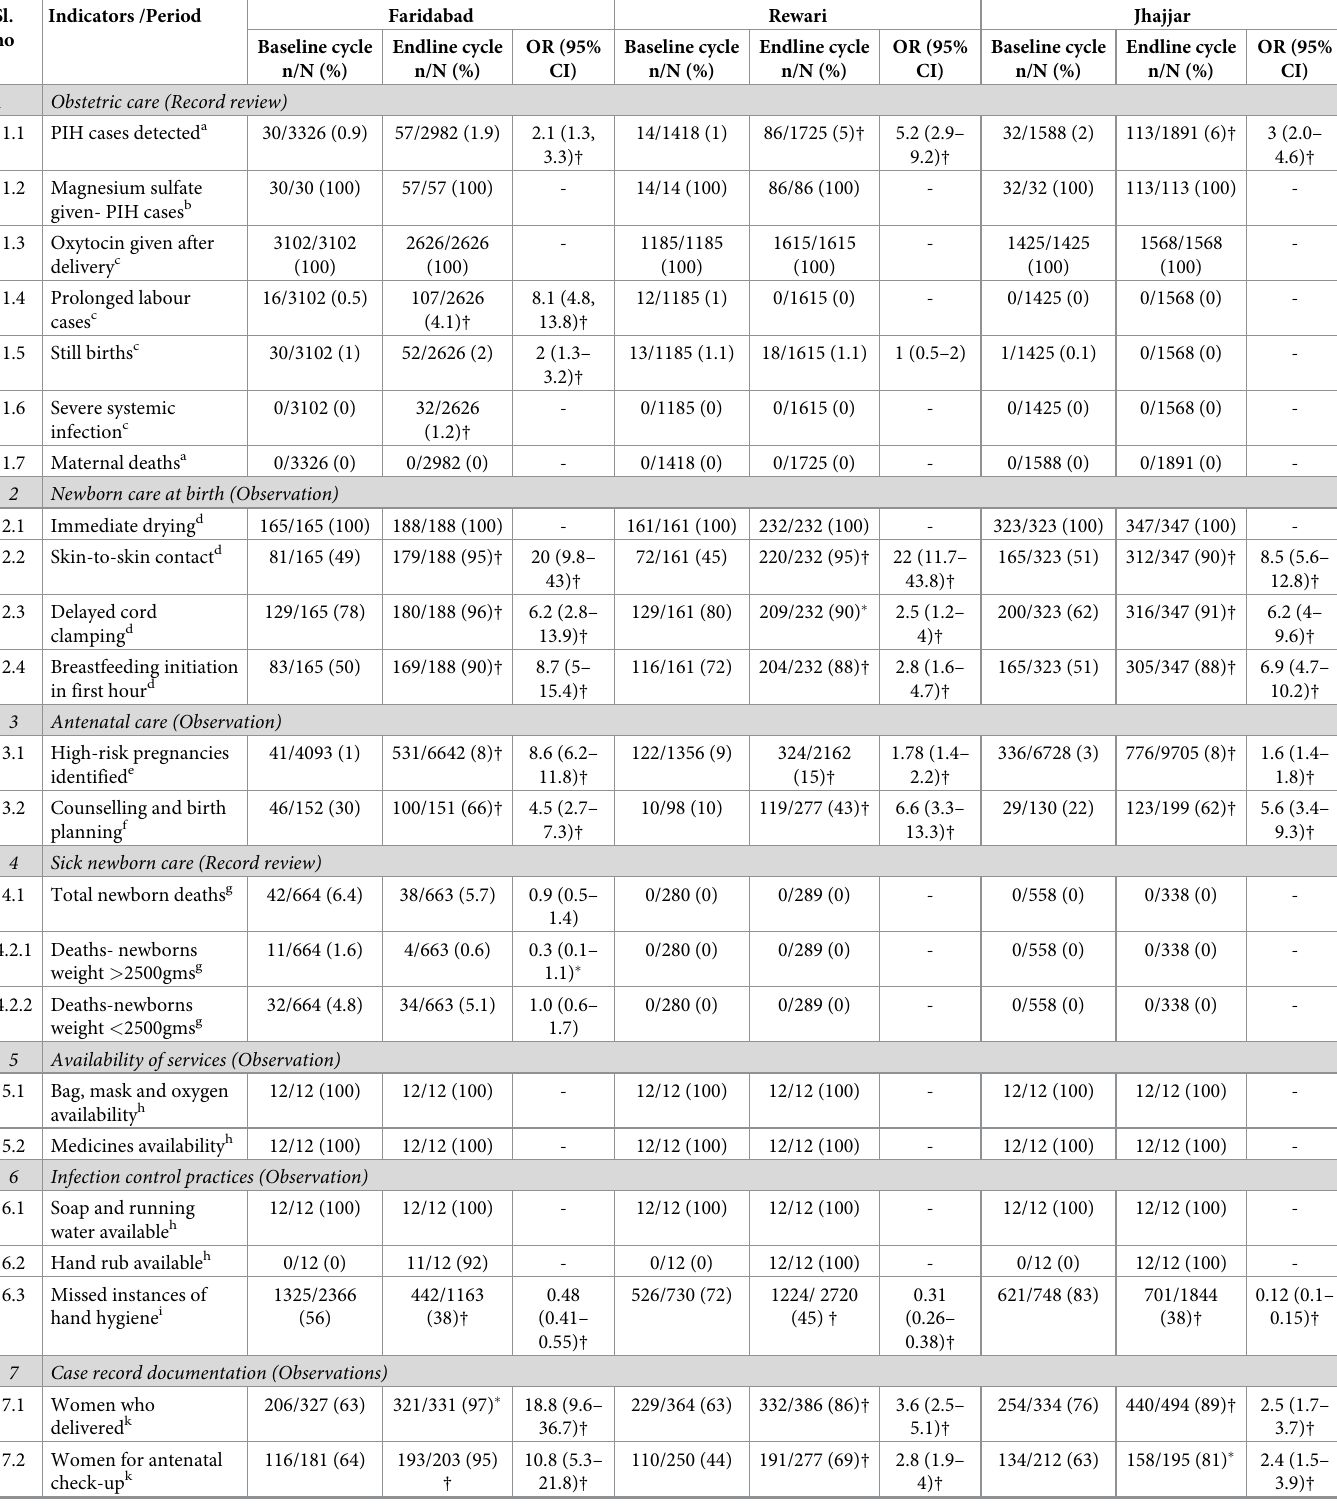
Table 2. Changes in the key outcome indicators with intervention in the districts. Sl.